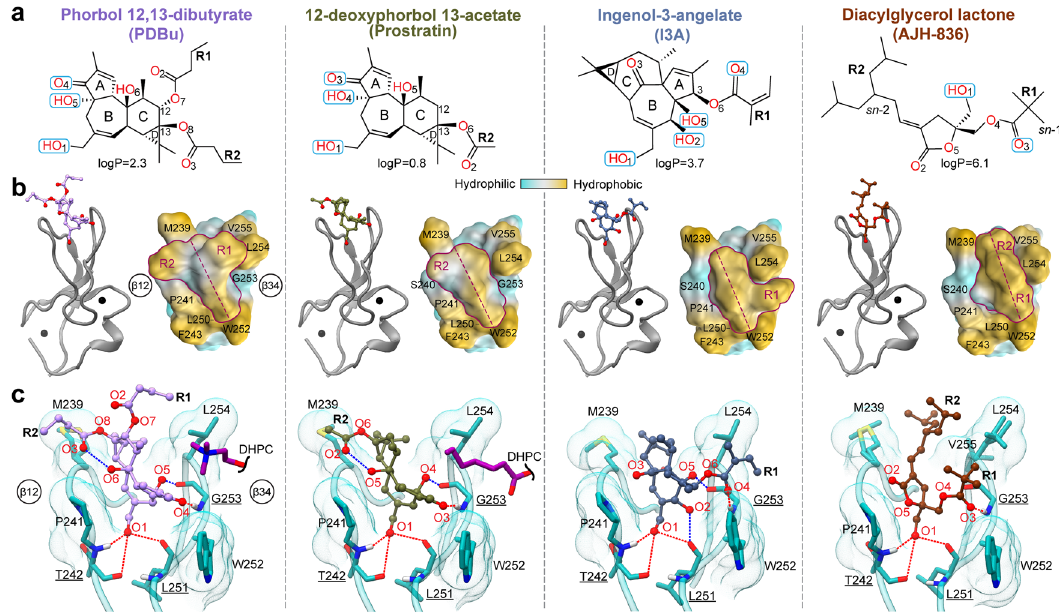
Fig. 5 Structures of the C1B δ -ligand complexes reveal the interaction modes of PKC agonists. a Chemical structures and polar groups involved in hydrogen-bonding interactions with C1B δ of PKC agonists. The numbering of oxygen atoms follows the ALATIS system. b 3D structures of the complexes (PDB IDs from left to right: 7KNJ, 7LCB, 7KO6, and 7LF3) showing the ligand placement in the binding groove. The shape of the ligands ’ hydrophobic cap, viewed from the top of the loop region, is outlined in maroon. The hydrophobic ridge that traverses the groove is marked with the maroon dashed line. c Ligand interactions with Thr242, Leu251, and Gly253 (underlined) that recapitulate the DAG hydrogen-bonding pattern are shown with red dashed lines. Blue dashed lines show ligand-speci fi c hydrogen bonds, including the intra-ligand ones in PDBu and Prostratin. The depression created in loop β 34 by Gly253 in the PDBu and Prostratin complexes accommodates DHPC molecules in the